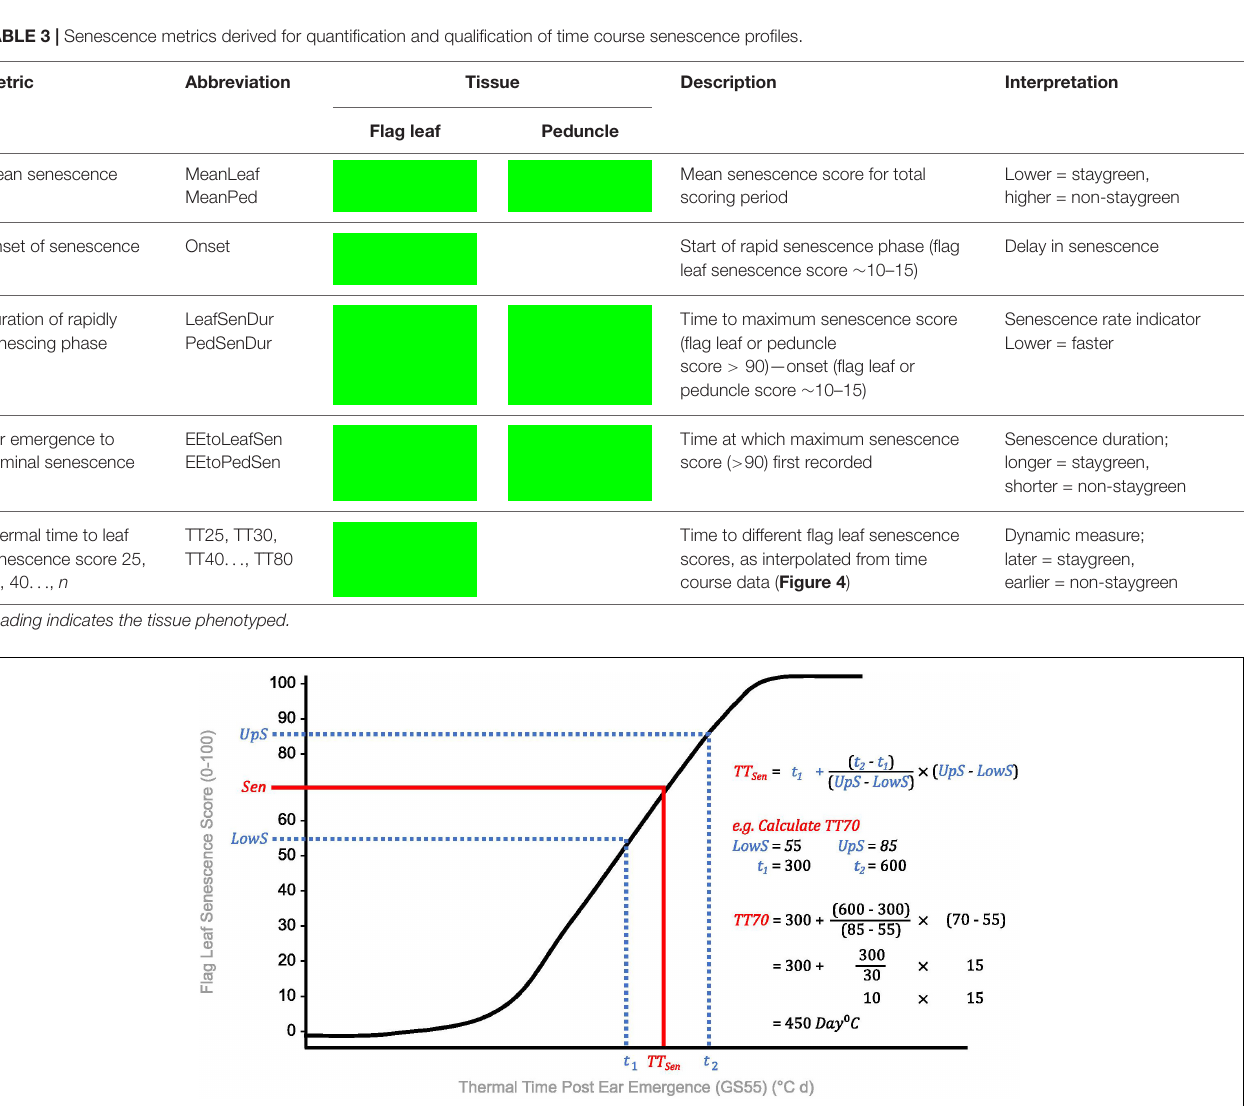
B) to 0.91 (Staygreen A), P ≤ 1.8 × 10 − 5 ( Figure 5C ),